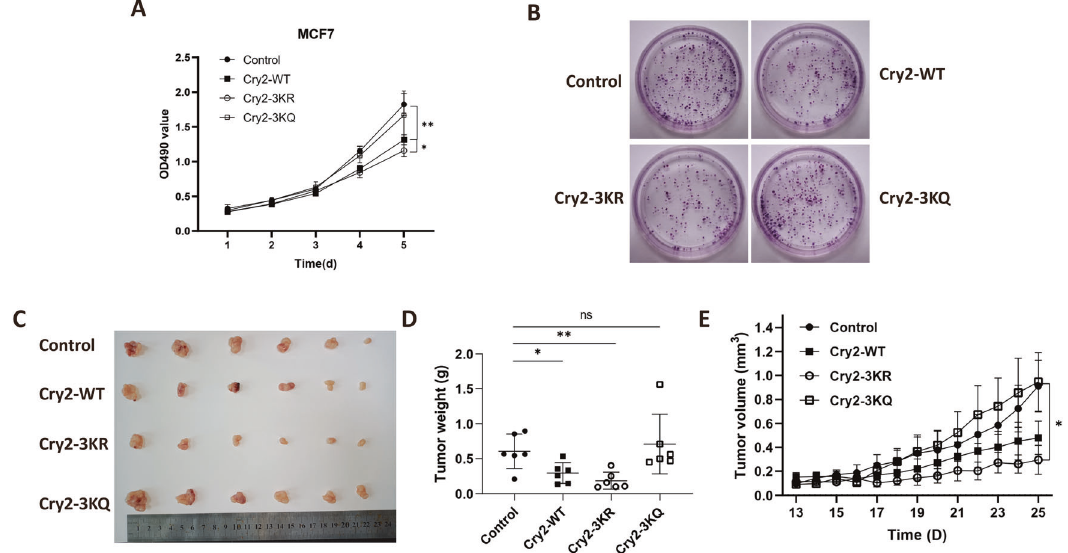
Fig. 5 Acetylation of Cry2 in breast cancer cells impairs its ability to inhibit cell proliferation. A Cell viability was analyzed by CCK8. Means ± SD, n = 5. * p < 0.05; ** p < 0.01. B Cell growth was determined by Colony formation. C Xenograft tumors from MCF7 cells. D , E Weight and growth of tumors in ( C ). Means ± SD, n = 6. * p < 0.05; ** p < 0.01; ns, no signi fi cance.